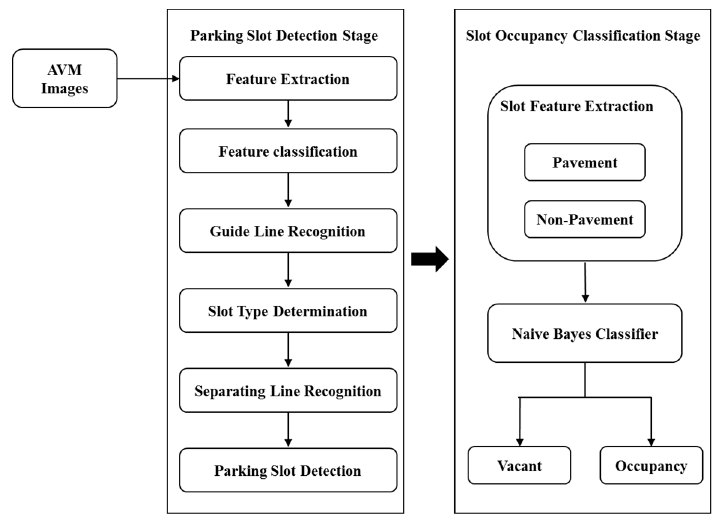
Figure 3. Algorithm flowchart.